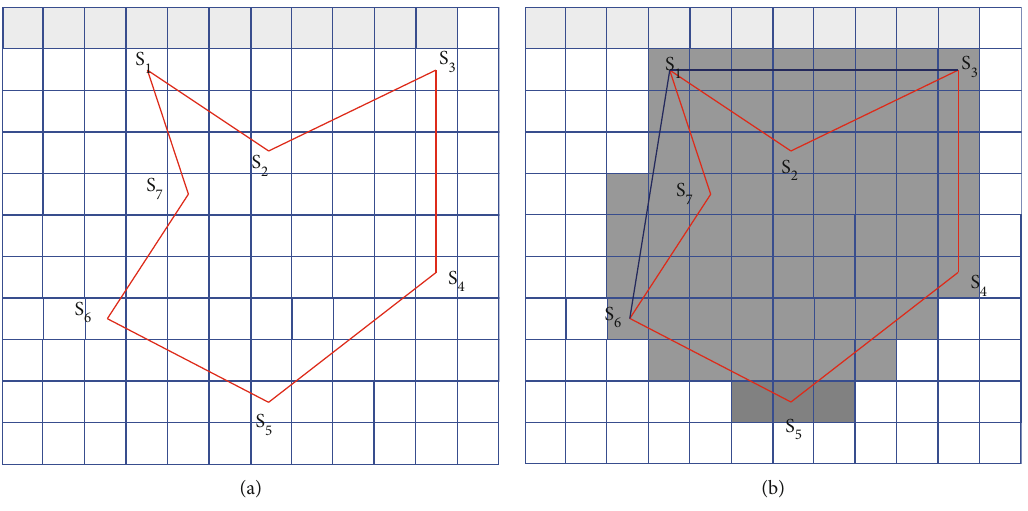
Figure 2: The convex fi lling of a concave polygon. (a) Before treatment. (b) After treatment.